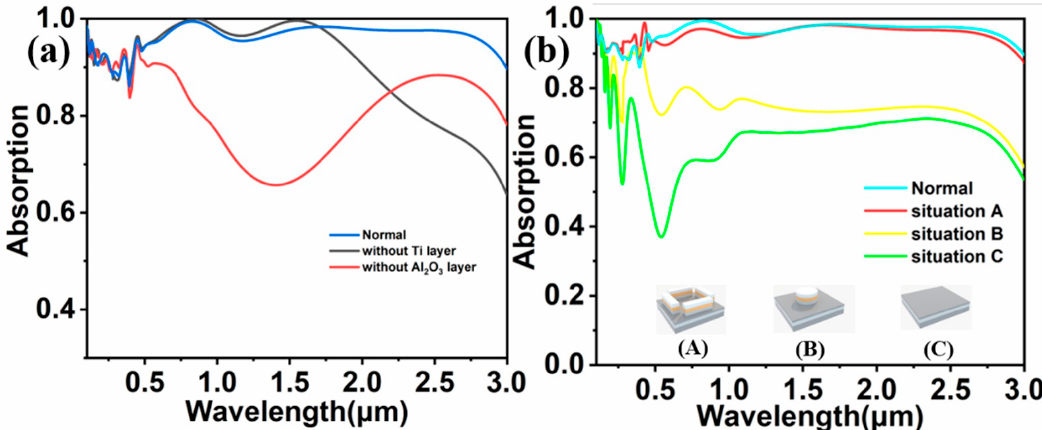
Figure 7. The simulated absorption spectra under different substrates ( a ) and simulated spectra of different surface structures ( b ).